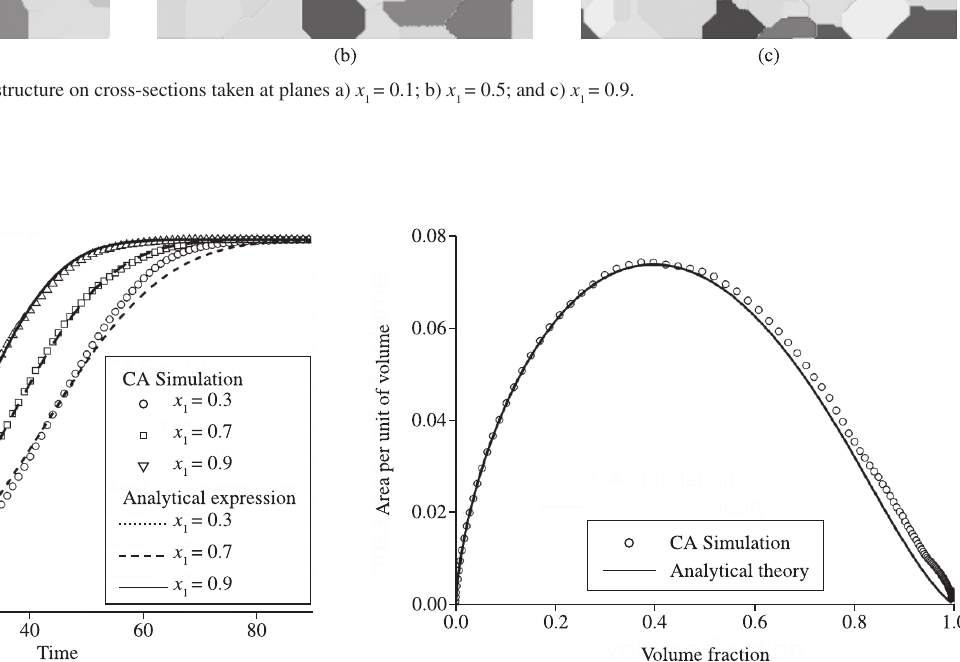
Figure 5. Mean volume density, V x = 0.03, 0.5, and 0.9. 1